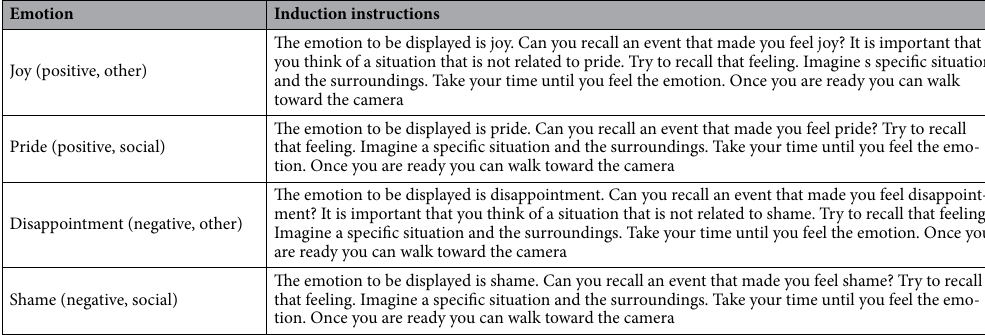
Table 3. Emotion induction